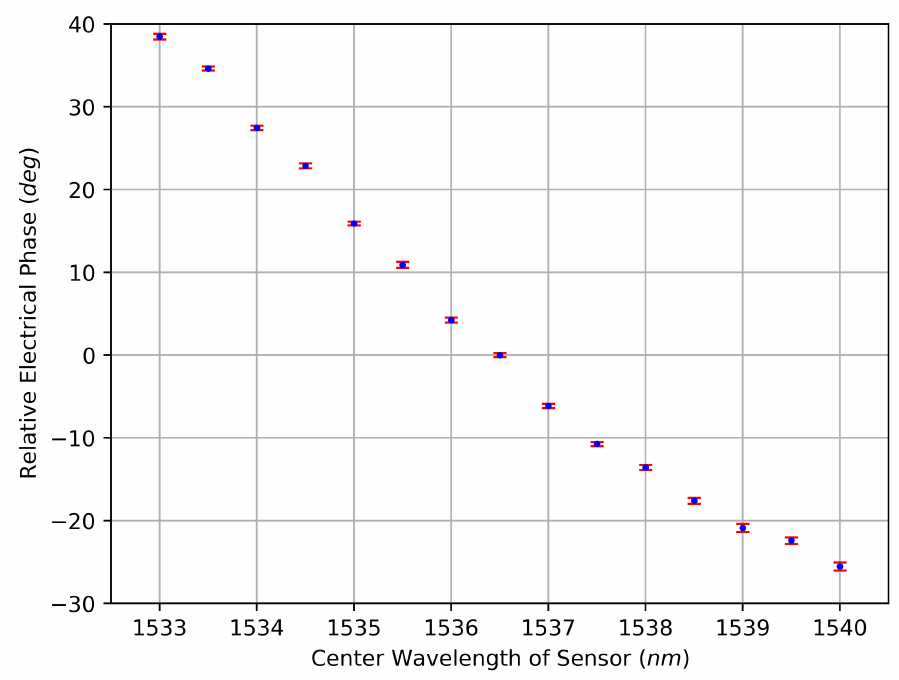
Figure 3. Measured dependency of the electrical phase from the center wavelength of the sensor. Mean (blue) and standard deviation (red) of 50 readings per sensor